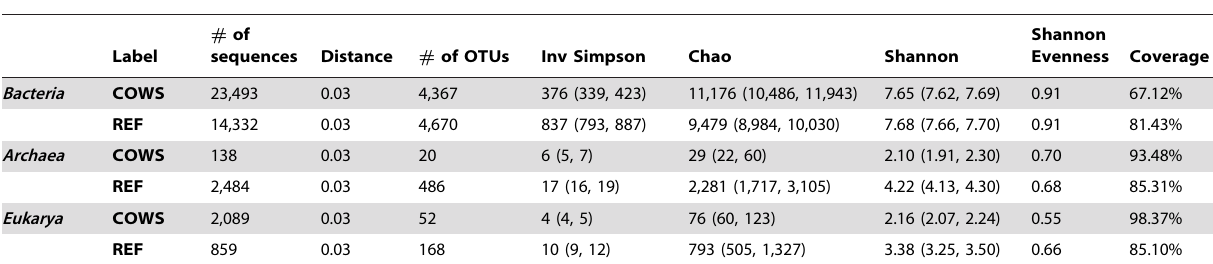
Table 1. Diversity among 12 cows and public repositories.